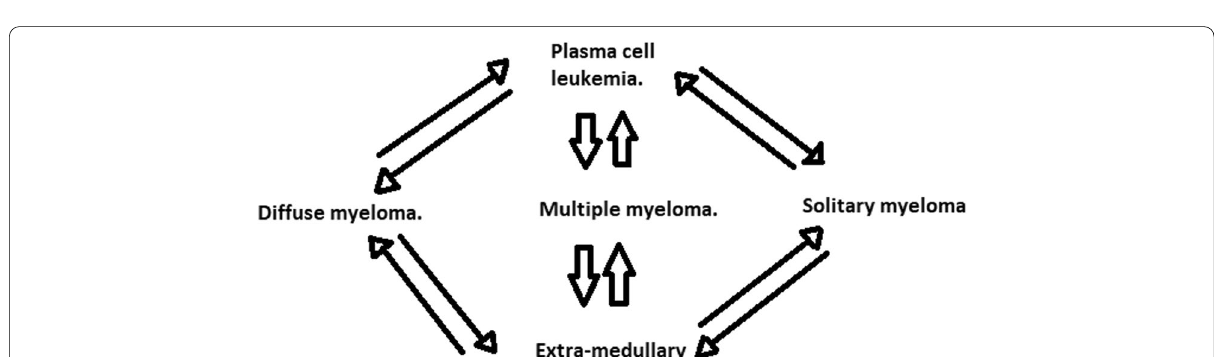
Fig. 3 Axial CT scan sections: thickening of laryngeal mucosa at the level of the epilaryngeal space with restriction of the laryngeal